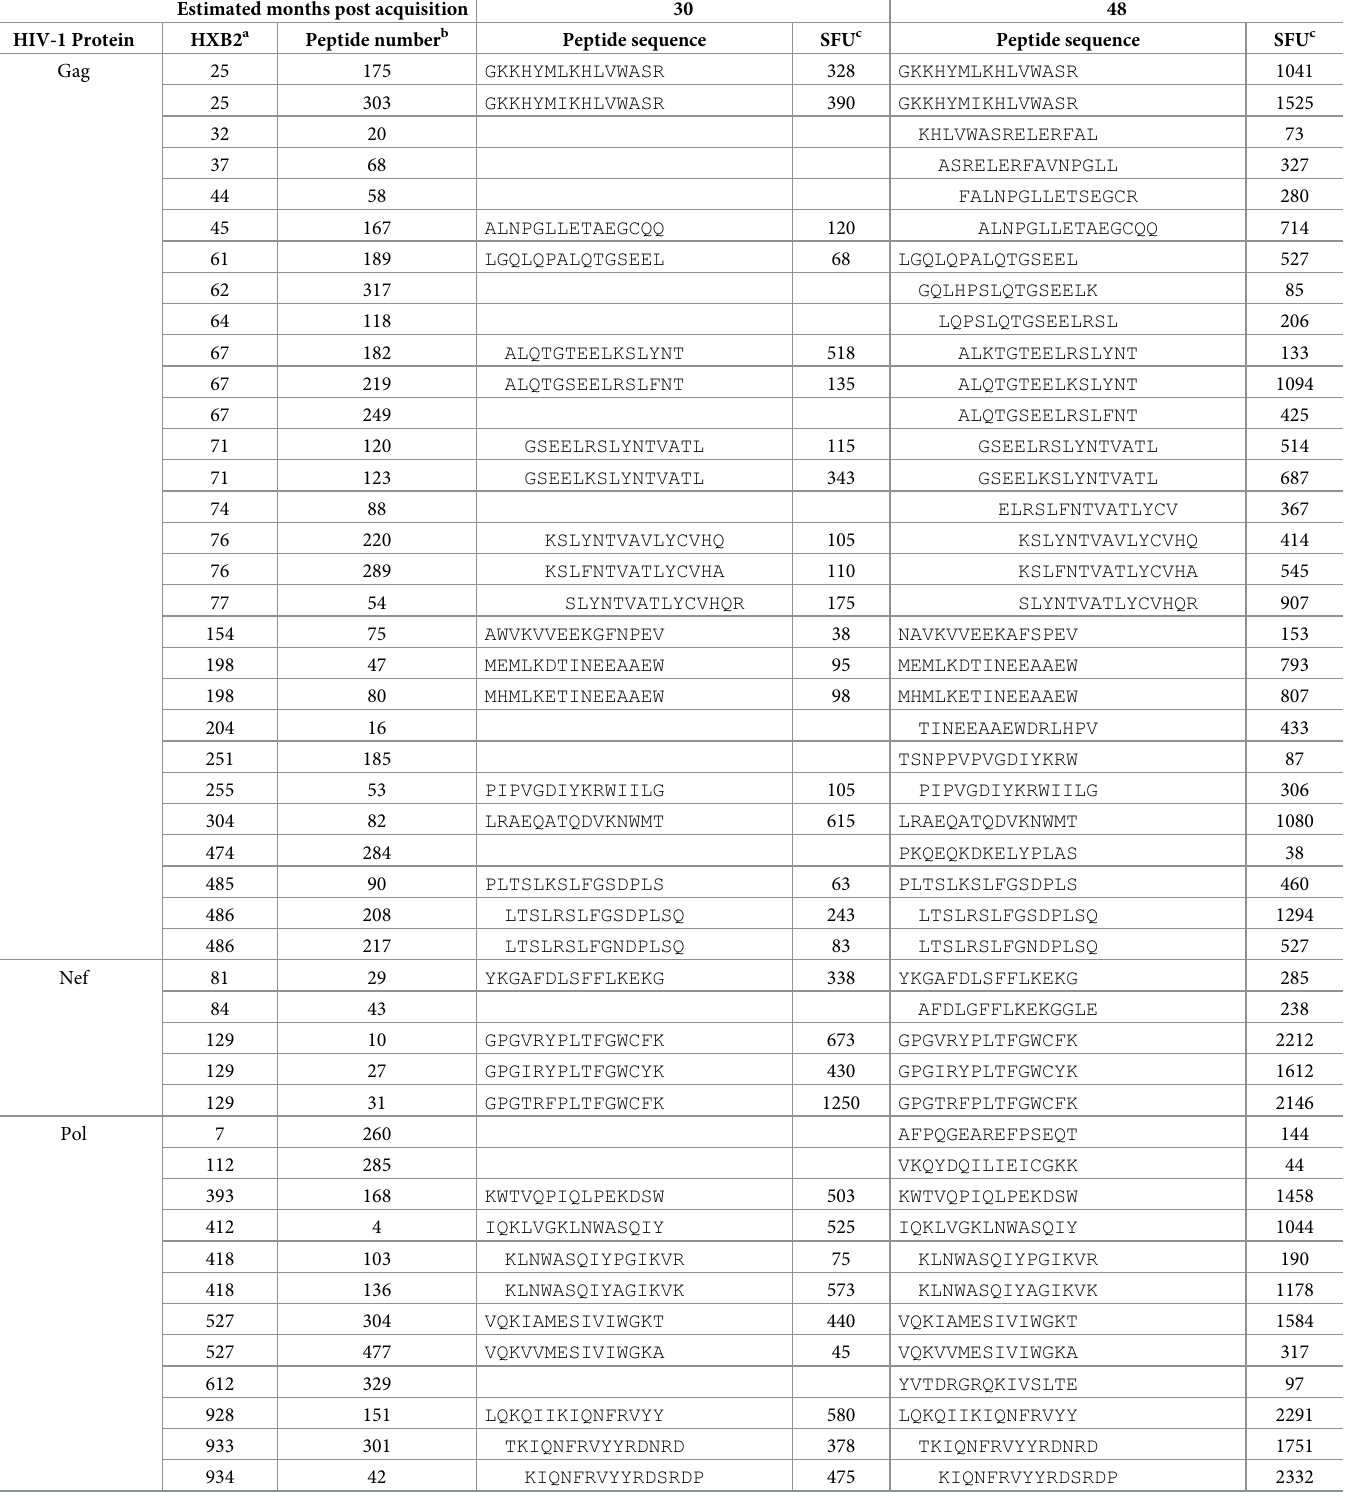
Table 5. PTE peptide recognition by subject 8 at two post HIV-1 acquisition time